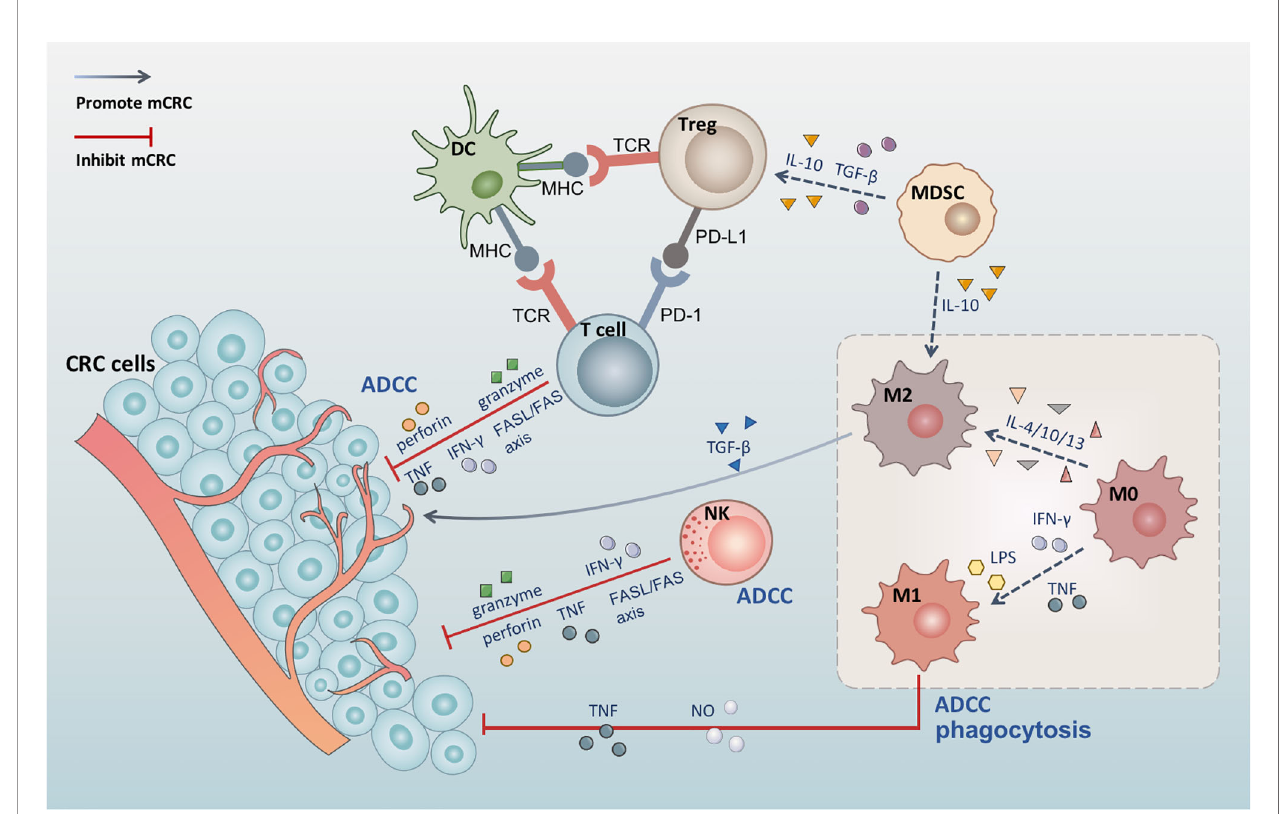
FIGURE 1 | The tumor immune microenvironment of colorectal cancer. DC activates T cells through the combination of the MHC and T cell receptors. Tregs inhibit the immune effects of T cells via the PD-1/PD-L1 axis. Both NK cells and T cells can kill tumor cells through the Fas/FasL pathway, the perforin-granzyme pathway, and by releasing TNF and IFN- g . MDSCs can mediate the development of M2 macrophages and Tregs, which depends on IL-10, and produce TGF- b to induct Tregs. M0 macrophages polarize into M1 macrophages under the effect of LPS, IFN- g , and TNF, while polarizing into M2 macrophages following induction by IL-4, IL-10, and IL-13. M1 macrophages also induce tumor cell apoptosis through phagocytosis, ADCC, and the release of TNF and NO. M2 secretes TGF- b and contributes to angiogenesis, promotes tumor cell EMT, and induces immunosuppressive